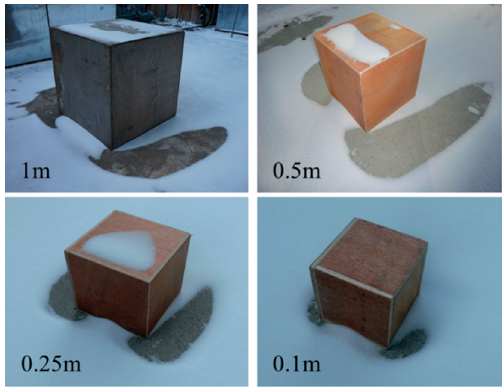
Figure 13. Photos of scale experiments.